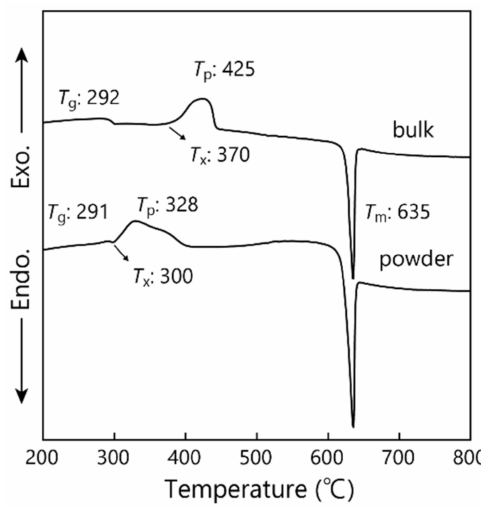
Figure 1. DTA curves of NaPO 3